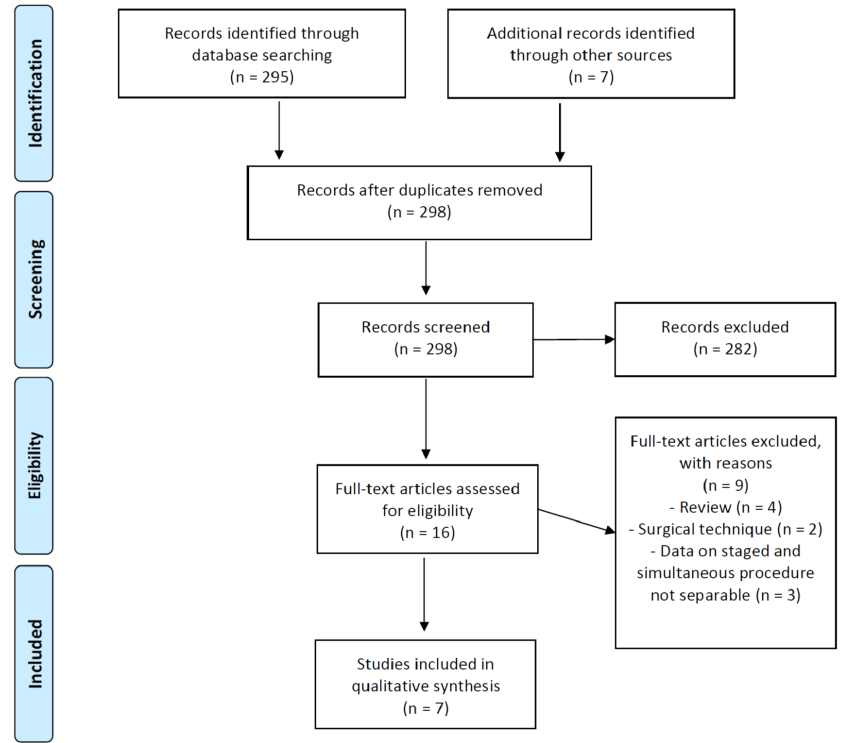
Figure 1. PRISMA flow-chart of included studies.